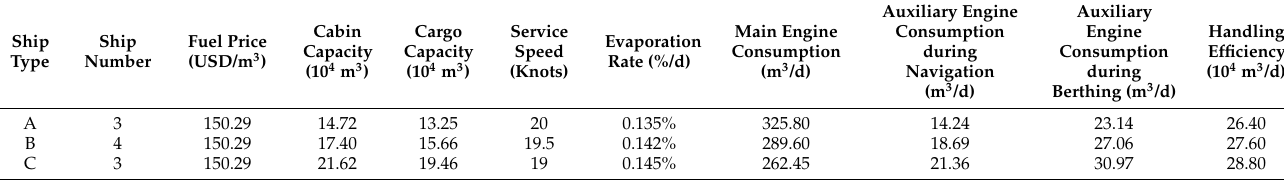
Table 2. Basic information on vessels.